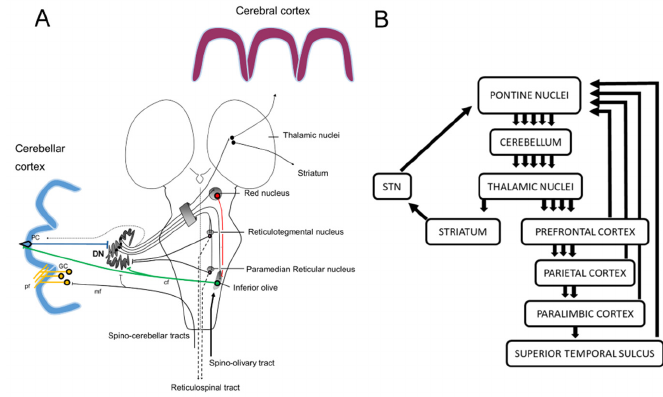
Figure 2. Illustration of the multiple loops between the cerebellum and cerebral cortex. ( A ) A corticonuclear projection from the Purkinje cell (PC) to the dentate nucleus (DN) is shown. The dotted line corresponds to a recurrent collateral ending in the the same sagittal zone at the origin of the PC to DN projection. The DN is involved in dentato-reticular reverberating loops, in the dentato-rubro-olivary triangle (Guillain-Mollaret) and in dentato-thalamo-cortical projections. The climbing fibers from the inferior olive project to both the DN and the PC via climbing fibers (cf). The mossy fibers of the spino-cerebellar tracts target the DN and the granule cells (GC) at the origin of the parallel fibers (pf). The afferents to the DN from the locus coeruleus and the raphe nuclei are not illustrated. Both the spinocerebellar tracts and the trigeminocerebellar tracts (not illustrated) relay information from the limbs and head / face, respectively. ( B ) Multiple loops running in parallel from the cerebellum to the cerebral cortex and to the striatum. The striatum projects to the subthalamic nucleus (STN) which targets pontine nuclei (disynaptic projection from the STN to the cerebellar cortex). The cerebellum receives not only corticopontine a ff erents from motor / nonmotor areas, but also information from the superior colliculus, the mammillary bodies and projects towards the ventral tegmental area (VTA), the locus coeruleus and the hypothalamus, which are connected with the limbic / paralimbinc regions linked to emotional processing (cerebro-cerebellar-limbic loops, not illustrated). The so-called limbic cerebellum engages mostly midline areas of the